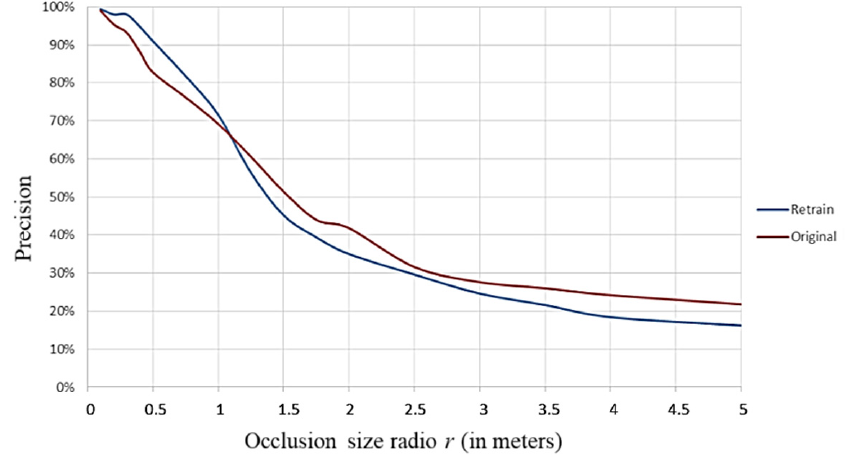
Figure 11. Comparison of precision of the re-trained and original CNN with noise level variation. Re-training with occlusions showed a turning point in the results obtained (Figure 12). Up to r = 1 m, the classification with small occlusions improved up to 10% and the misclassification effect was slowed down. However, from r = 1 m onwards, the reverse effect occurred, and the results worsened. This turning point is related to the size of the occlusion concerning the size of the object, as many small objects with occlusions of r = 1 m to 1.5 m started to occlude almost entirely. Applying occlusions of radius greater than r = 1.5 m, most of the objects that conserved information were the large ones, mainly pole-like objects. When these objects were partially occluded, the resulting sample was usually only a pole, which was very difficult to identify.